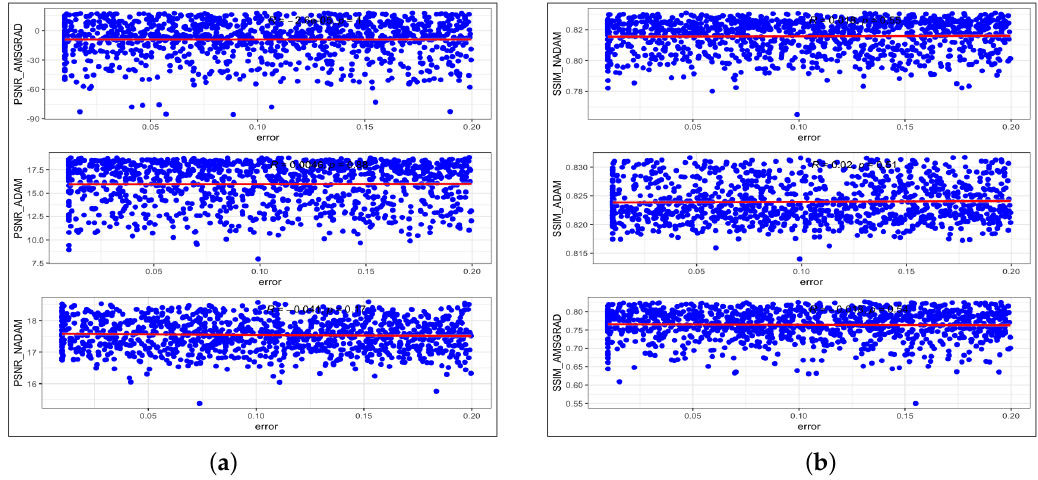
Figure 9. Correlation between initial guess error and ( a ) PSNR and ( b ) SSIM for different optimizers. The resulting Spearman’s coefficient R and the p -value are shown at the top of each